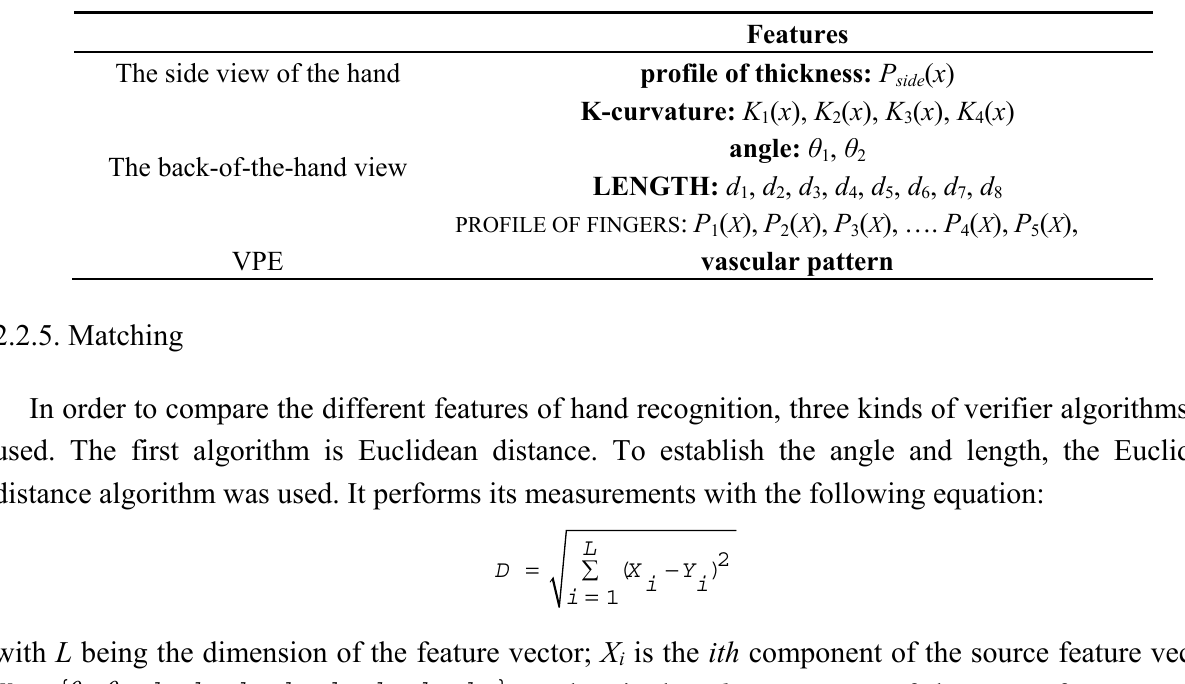
Table 2. The features of hand